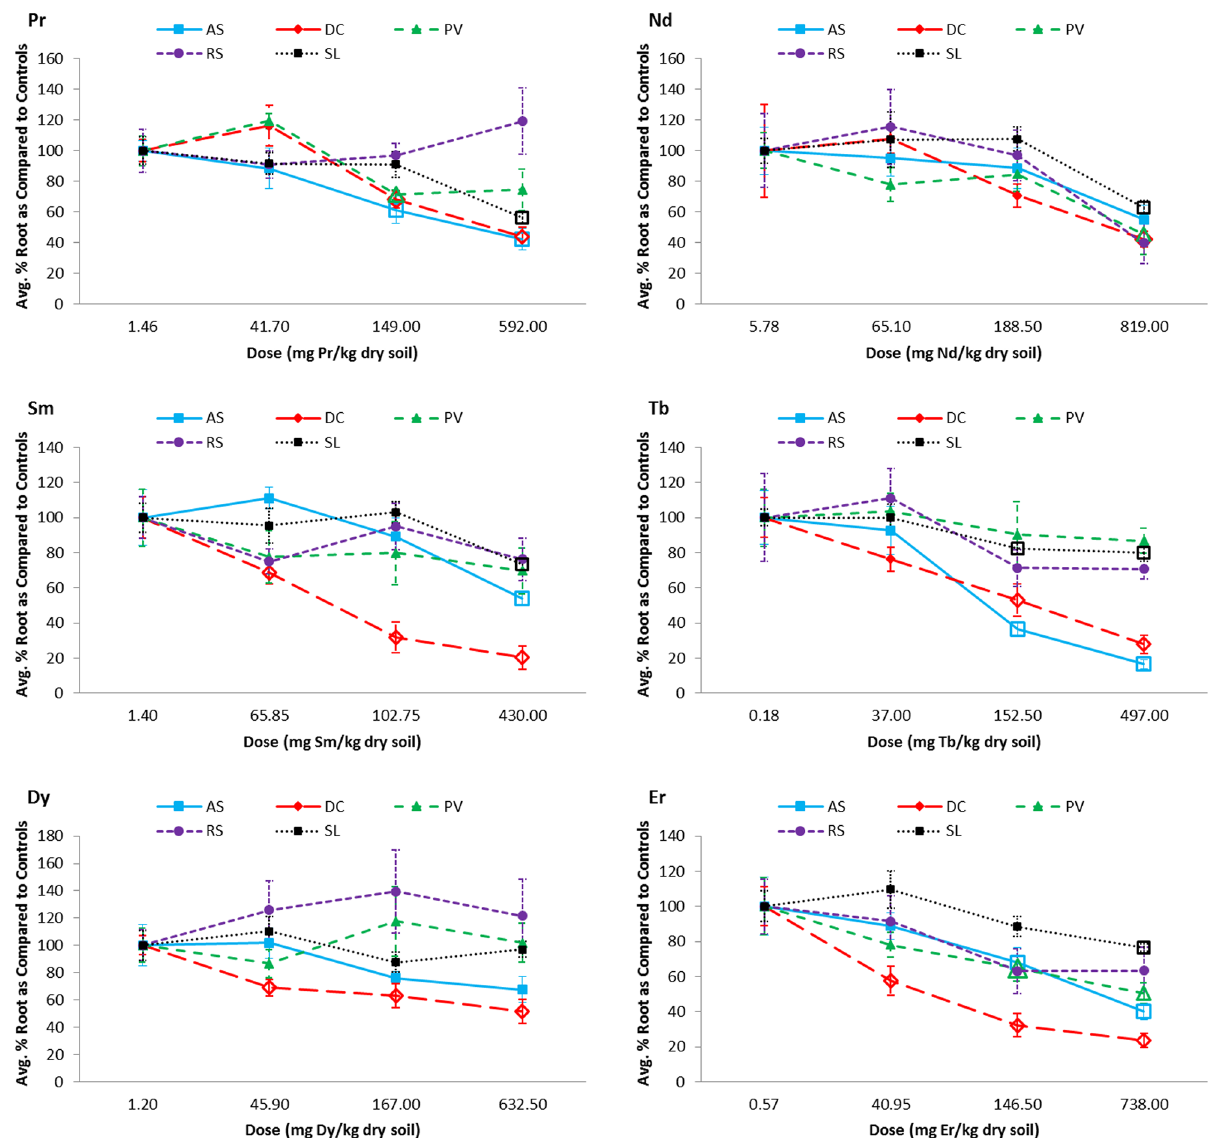
Fig 2. Dose-response curves for the belowground, root dry biomass (and including the radish bulb for Raphanus sativus ) of all five tested plant species grown in rare earth element (REE) contaminated soils. Only the controls, 2 nd , 4 th , and 6 th REE doses were evaluated. Biomass is presented as the average percent biomass as compared to the controls, such that the controls always have a mean of 100%. Doses that were found to be significantly, negatively different from the controls based on statistical analyses using ANOVA (Dunnett's one-way post hoc comparison) or the Kruskal-Wallis test (Conover-Inman post hoc comparisons) are indicated with open bullets. Error bars represent standard error. AS = Asclepias syriaca , DC = Desmodium canadense , PV = Panicum virgatum , RS = Raphanus sativus and SL = Solanum lycopersicum